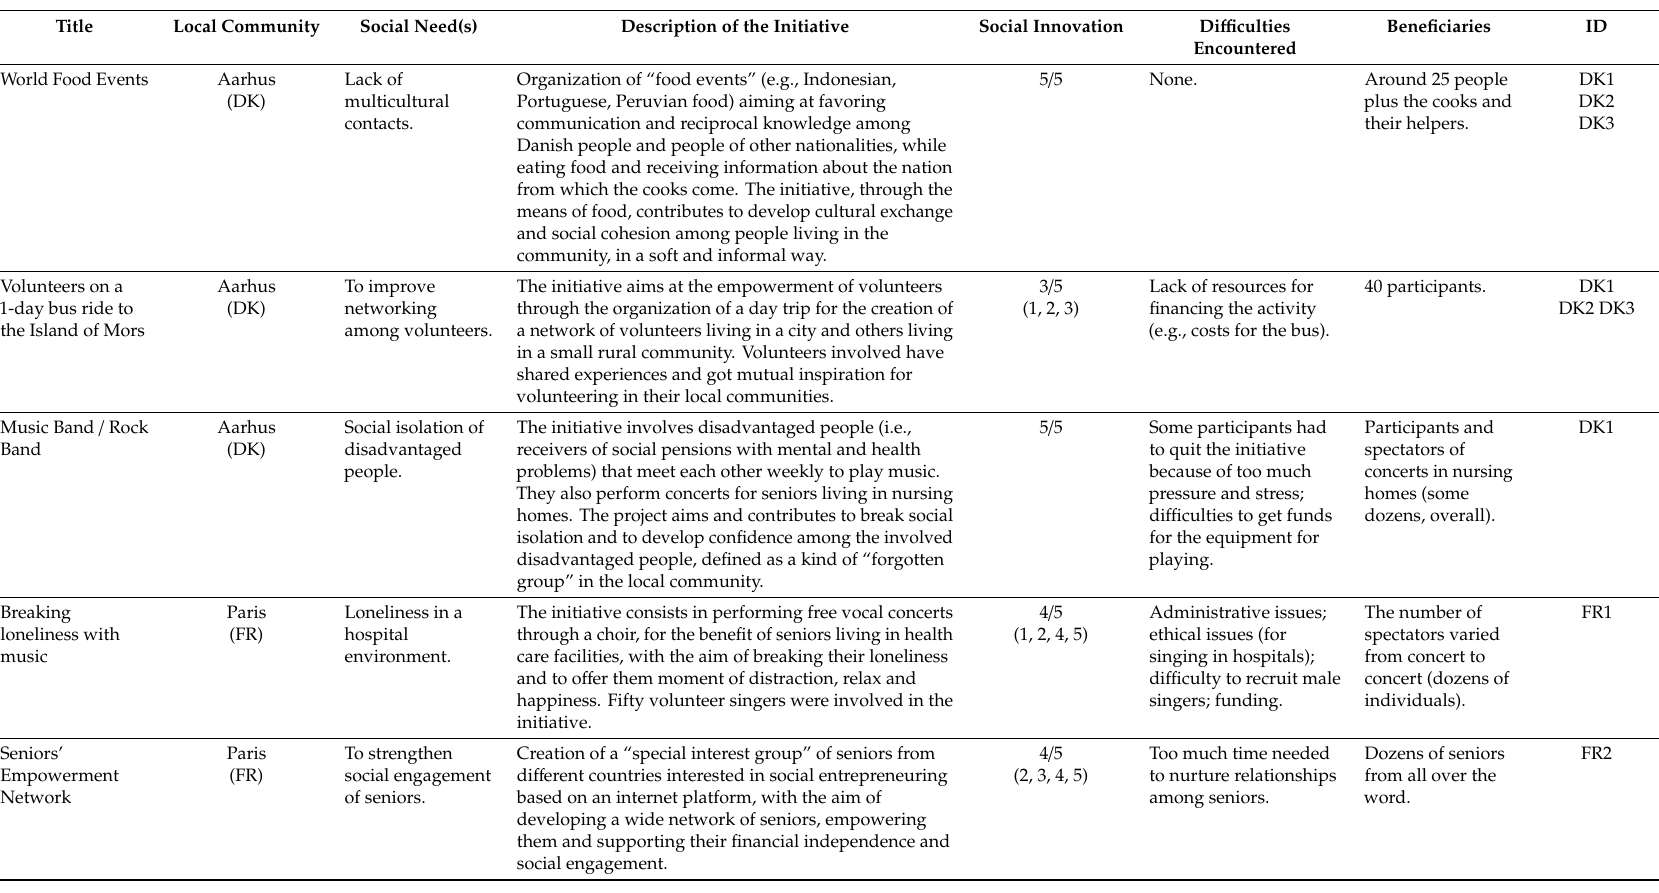
Table 2. Senior Social Entrepreneurship: description of the initiatives created by the seniors in the six European local